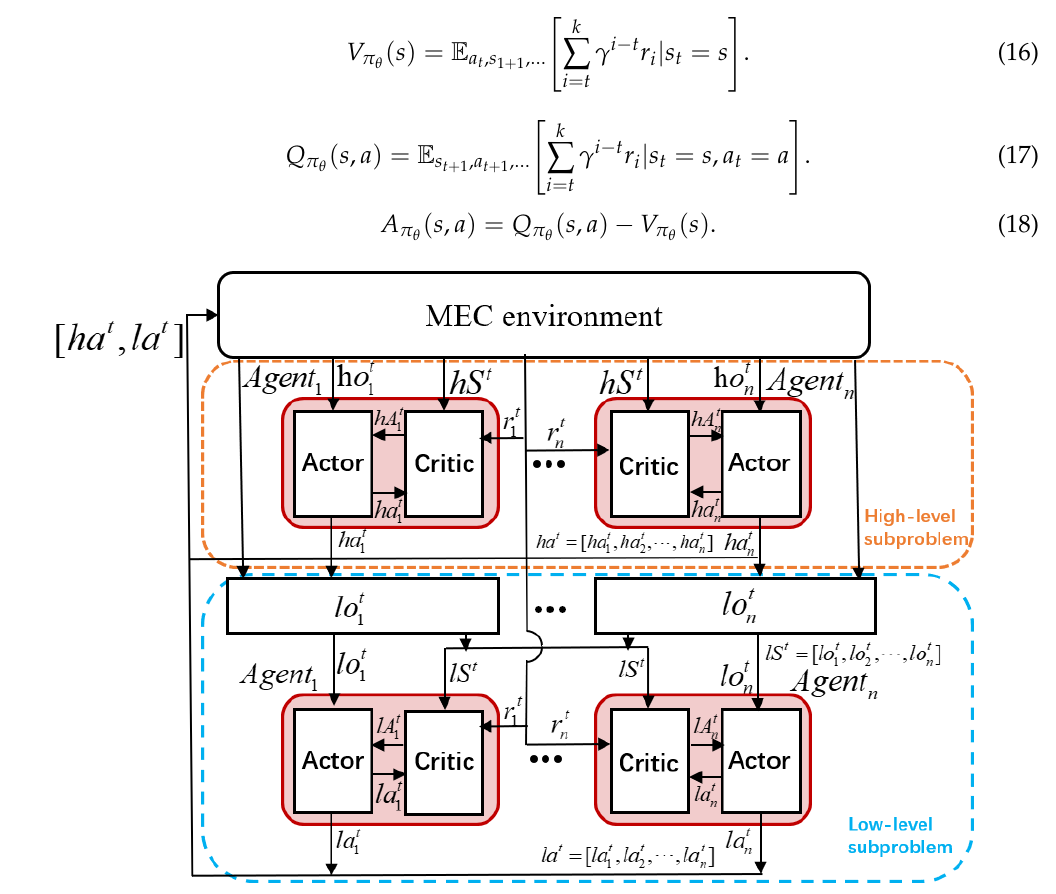
Figure 2. The HDMAPPO algorithm